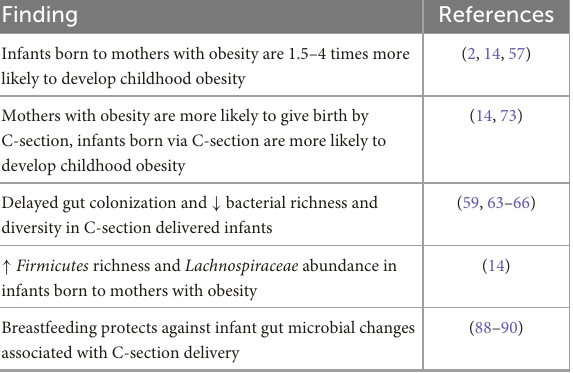
TABLE 1 Summary of the impact of human maternal obesity on offspring obesity and gut microbiome colonization. Finding